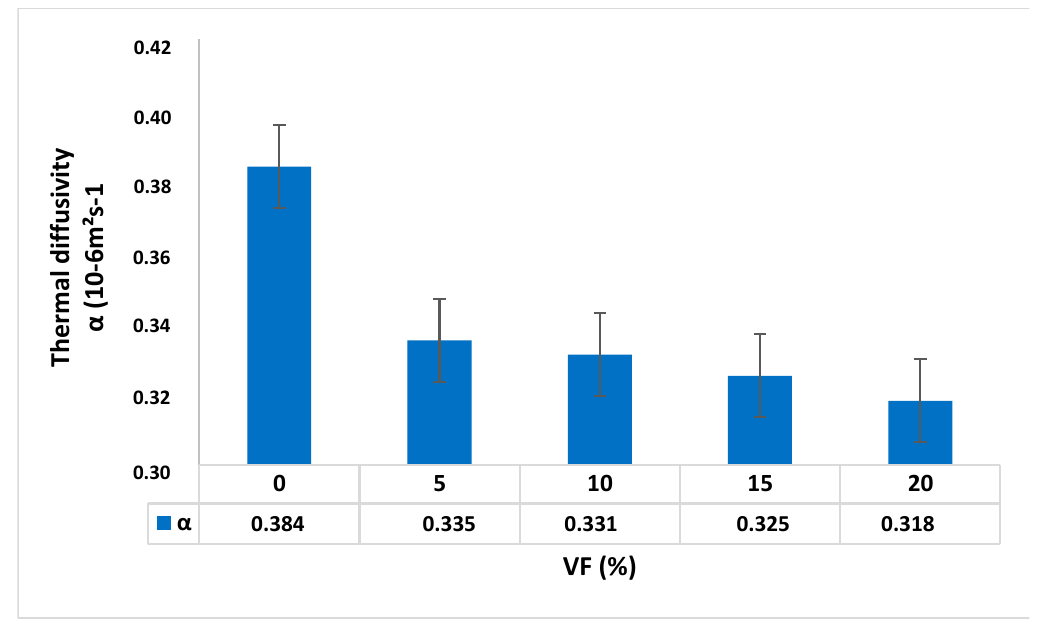
Figure 10. Effect of PO fibers on the thermal diffusivity of the mixtures.